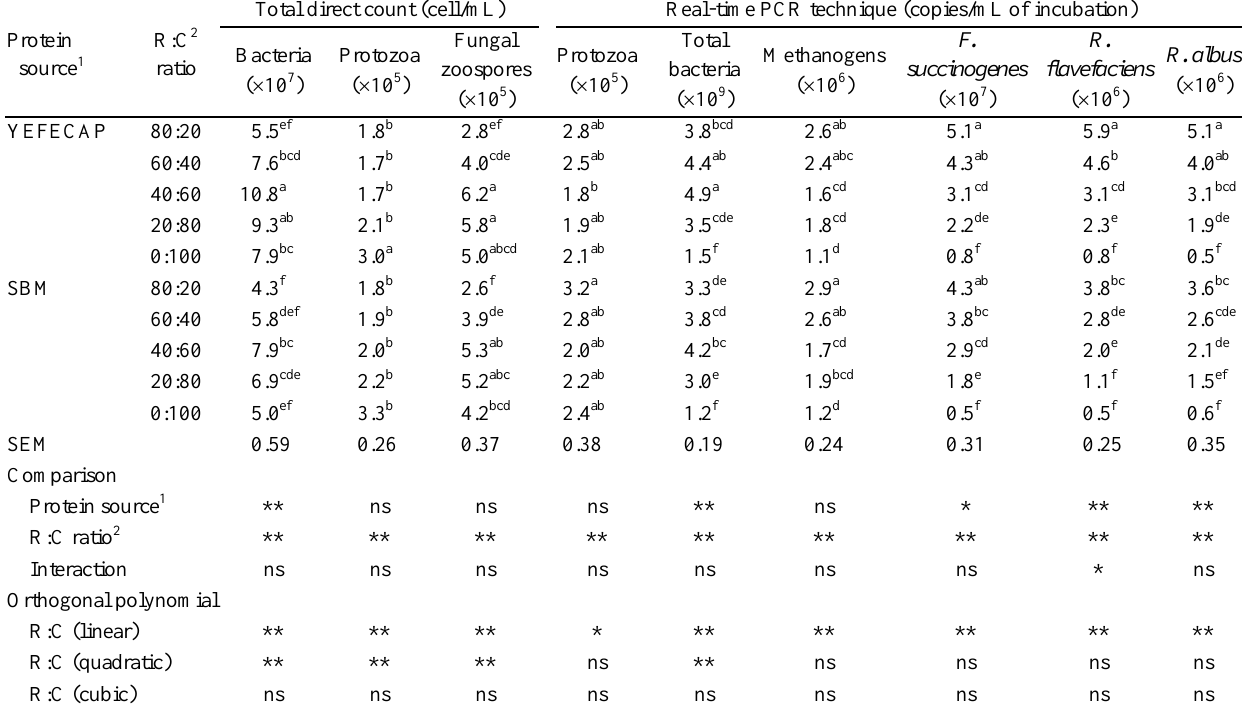
Table 4. Effect of protein source with roughage to concentrate ratio on ruminal microorganism Protein source